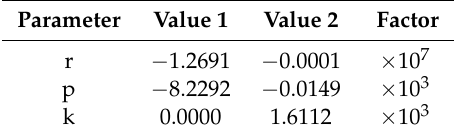
Table A1. Values obtained with the described MATLAB code.